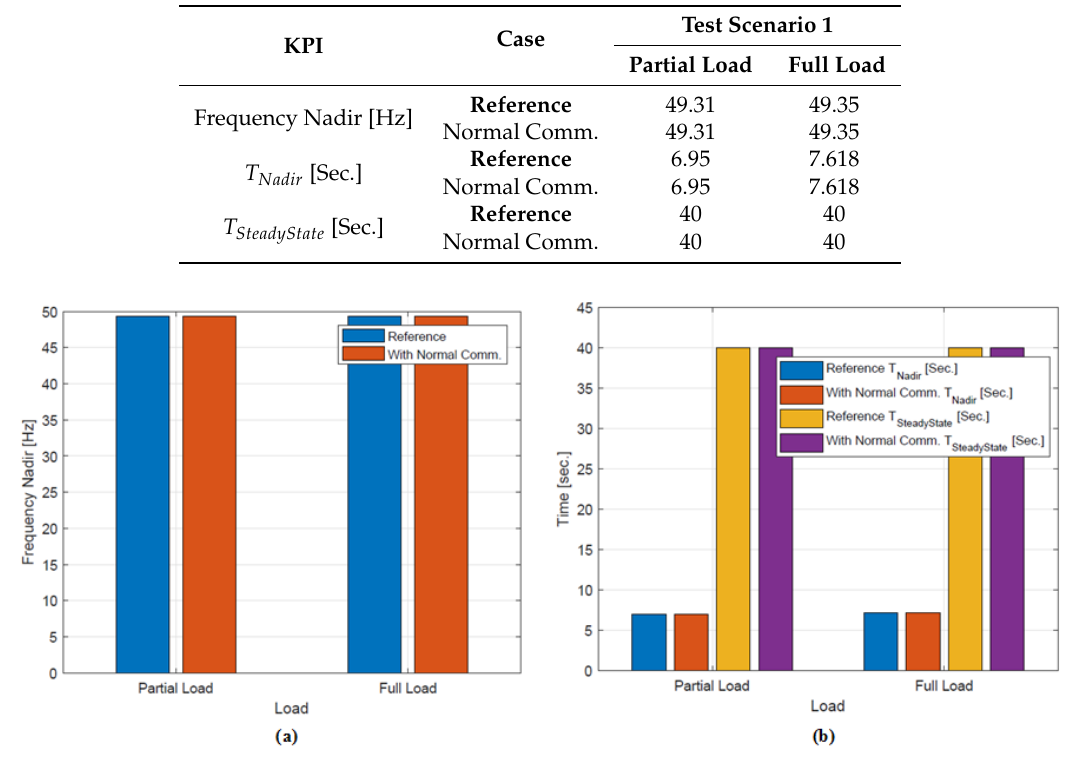
Table 6. Comparison of System Frequency KPIs obtained in Test Case -1 with that of Reference Frequency